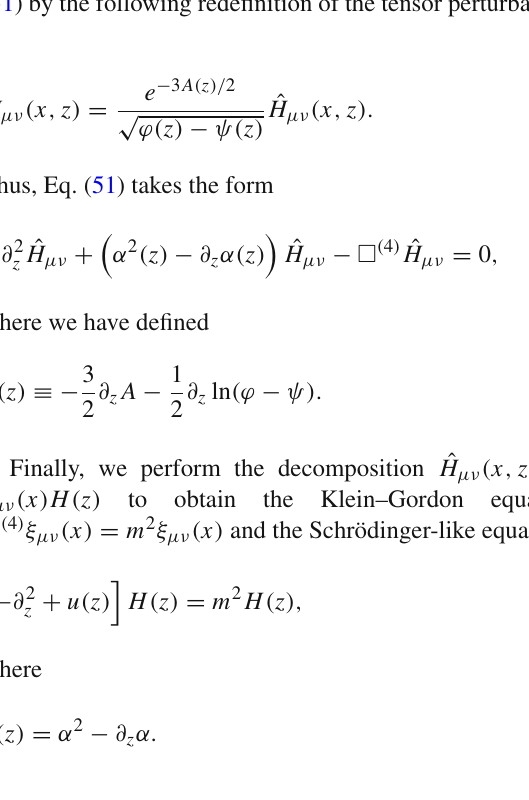
Fig. 7 Solutions for the potential V ( y ) from Sect. 3.4 with ϕ 0 = 1, ψ = − 2 and k = 1. Unlike previous cases, the general shape of the 0 3 potential is always the same for the allowed range of